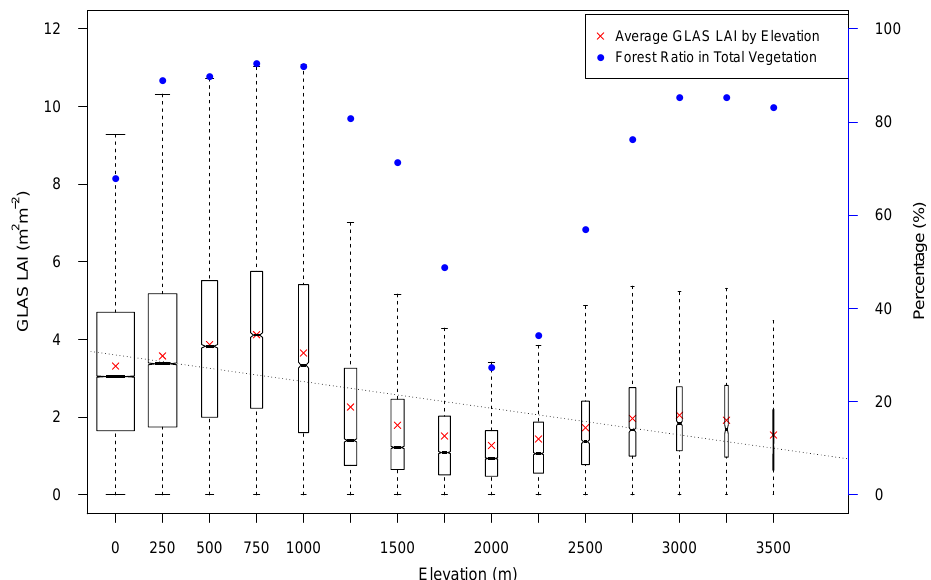
Figure 9. Distribution of GLAS LAI (left axis) and Forest Ratio – GLAS shots over forest divided by total shot numbers (right axis). Overall, there is a decreasing trend of LAI values as elevation increases, but deviations occur from this trend that are associated with elevational variation in the Forest Ratio, which was defined as the percentage of footprints classified as forests in total GLAS shots within each elevation group.